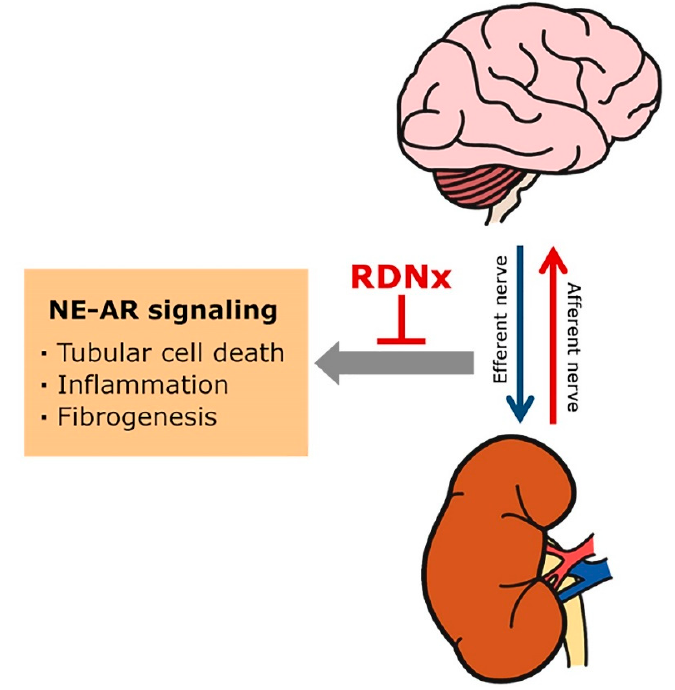
Figure 1. Renal sympathetic nerve-derived norepinephrine (NE) and adrenergic receptor (AR) in chronic kidney disease development and progression. Sympathetic efferent activation, which is generated in the central nervous system, contributes to sympatho-excitation in the vasculature and renal tubules, and mediate their effects via norepinephrine and adrenergic receptors (ARs). The increased renal sympathetic nerve-derived NE may trigger tubular cell death, renal inflammation, and fibrogenesis progression, leading to CKD. Renal denervation (RDNx) lowers NE in renal tissue after renal injury and has a protective effect against fibrogenesis and CKD progression.